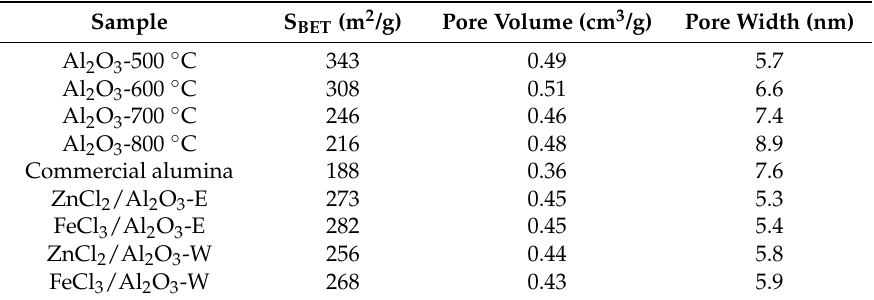
Table 1. Specific surface area (m 2 /g) and pore volume (cm 3 /g) of catalysts